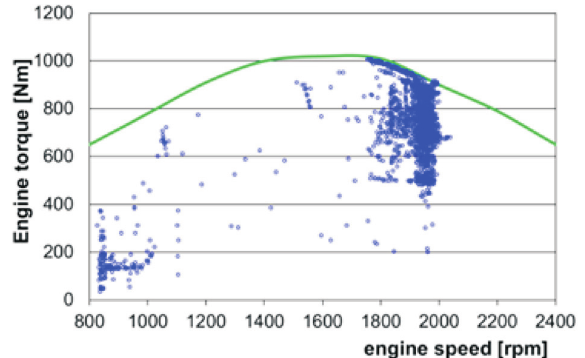
Fig. 8. Farm tractor engine parameters under actual operation (ploughing)